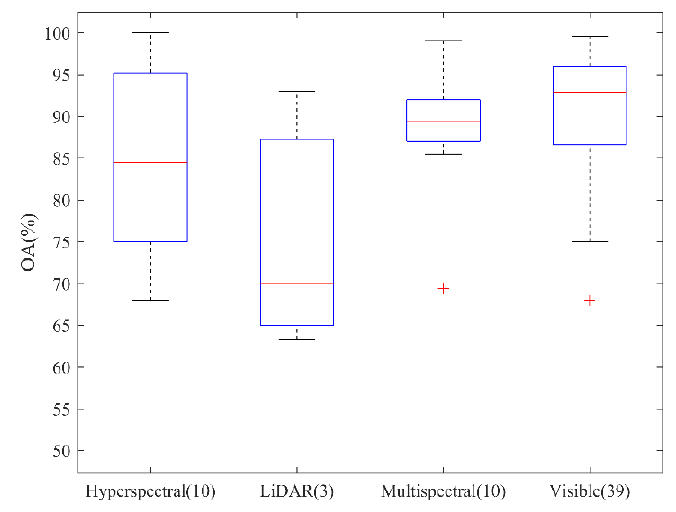
Figure 18. Overall accuracy vs. sensor types.